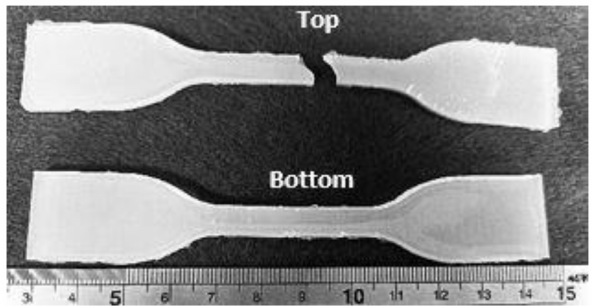
Figure 1. Original E640 sample ( bottom ) and stretched to fracture ( top